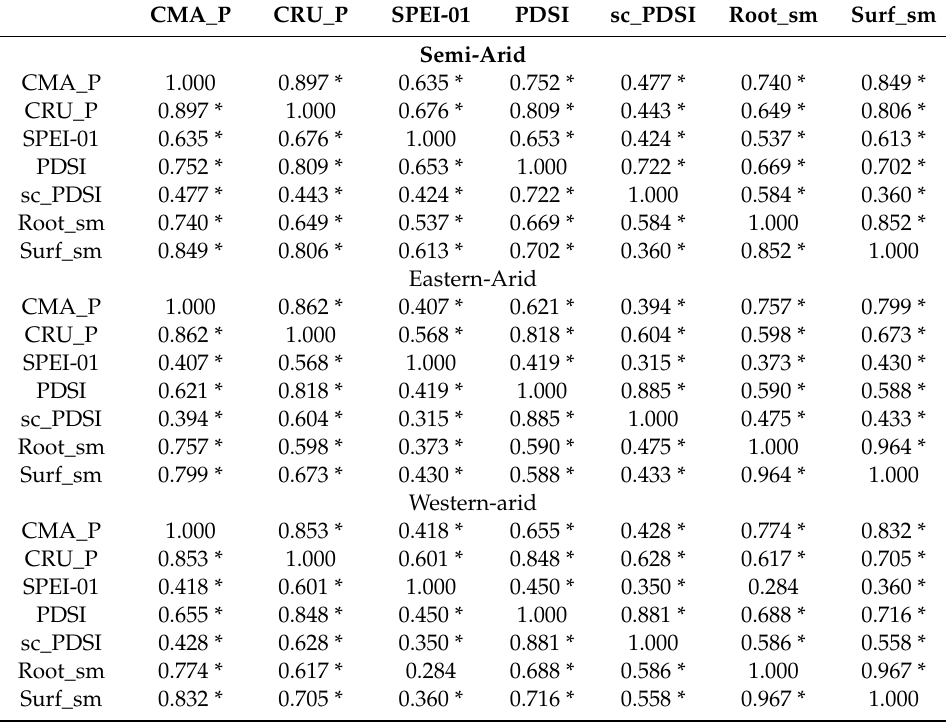
Table4. Theinterannualvariationofcorrelationsamongmultipledrynessindicatorsinthreesub-regions of the drylands of